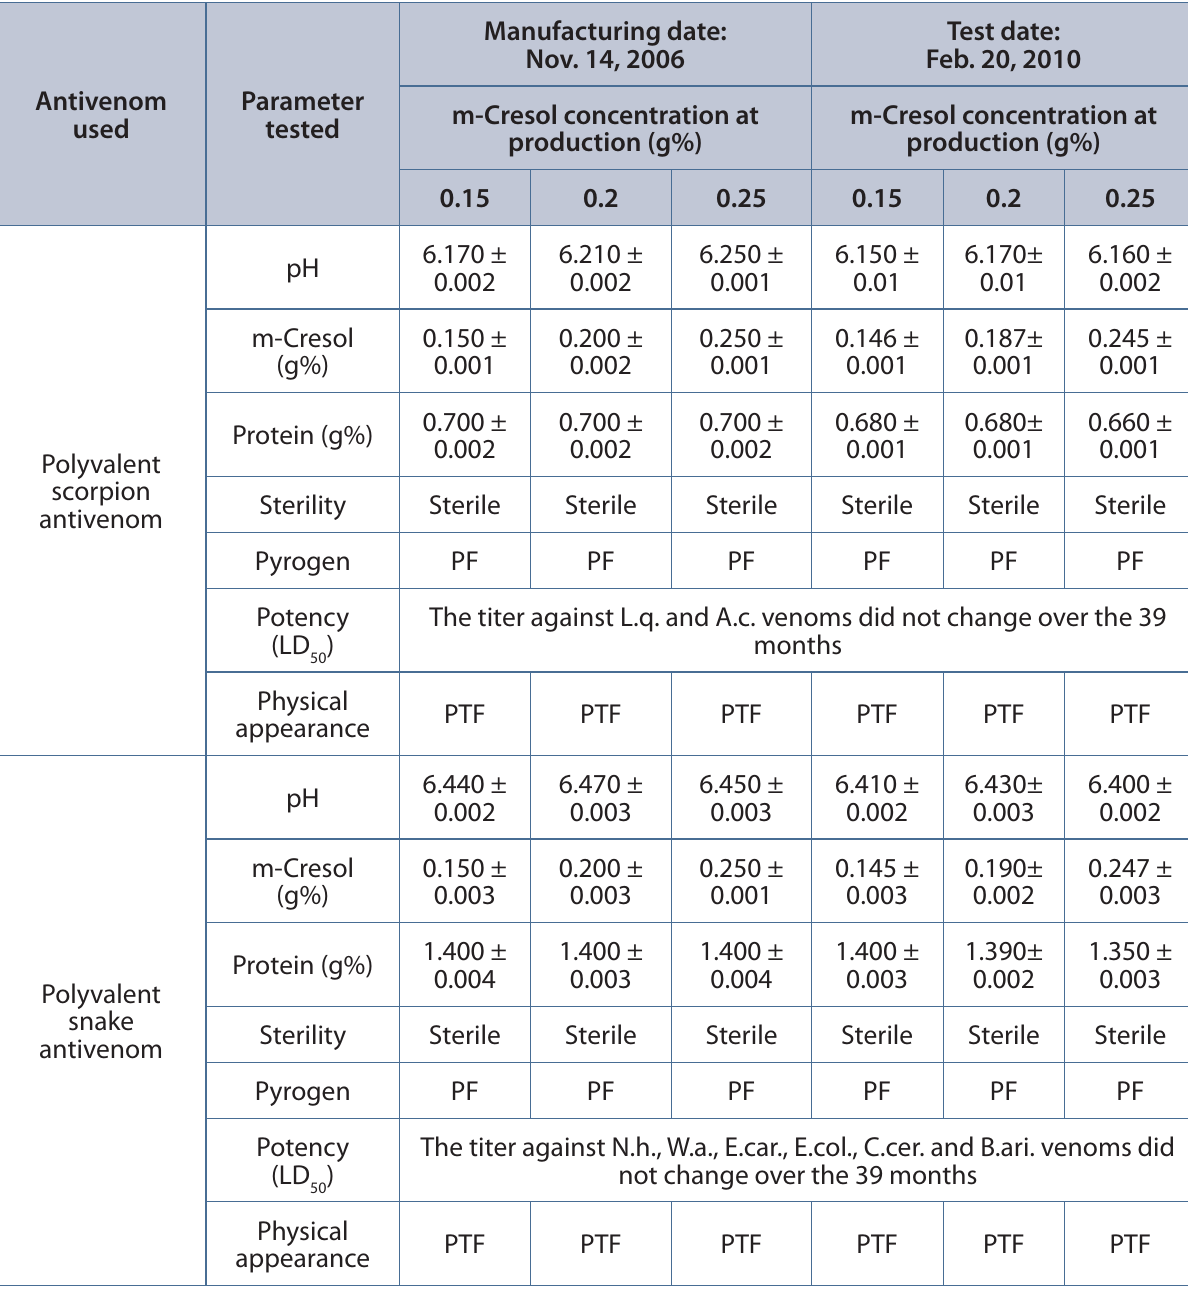
Values represent the mean of six samples followed by the respective standard error of the